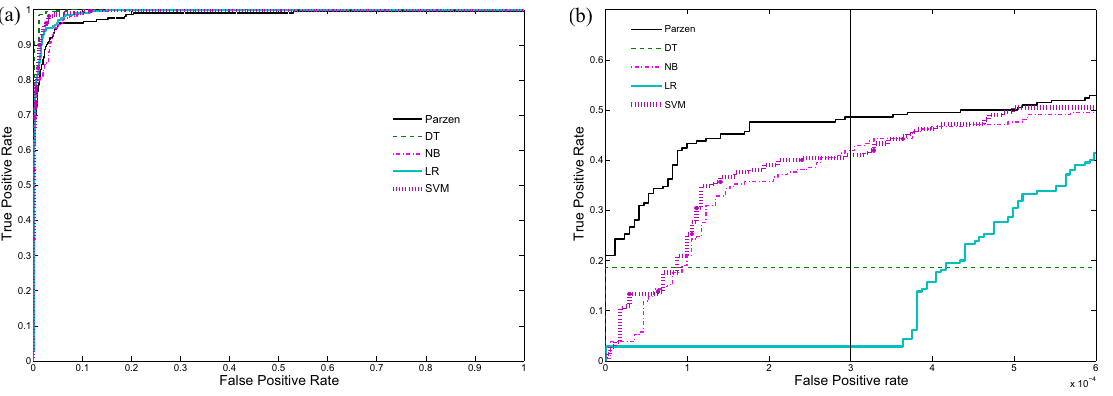
Figure 1: Example of ROC curve analysis: (a) Whole ROC curves for the different learning meth- ods evaluated. (b) Partial ROC curves for the different learning methods evaluated. The vertical line indicates the point where approximately the first 50 false-positive examples are